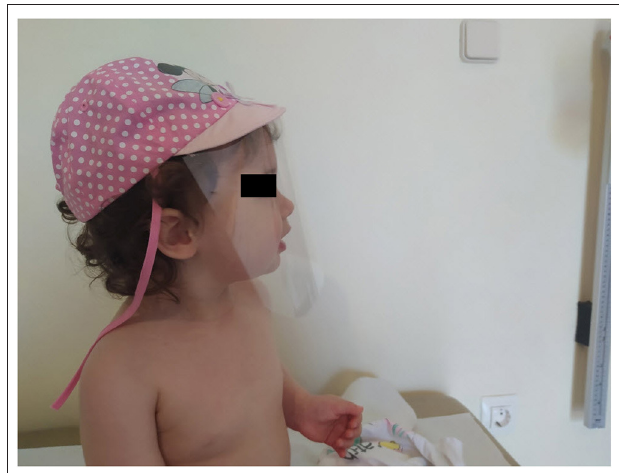
FIGURE 1 | A 19-month-old child wearing a handmade face shield. It is being been published with